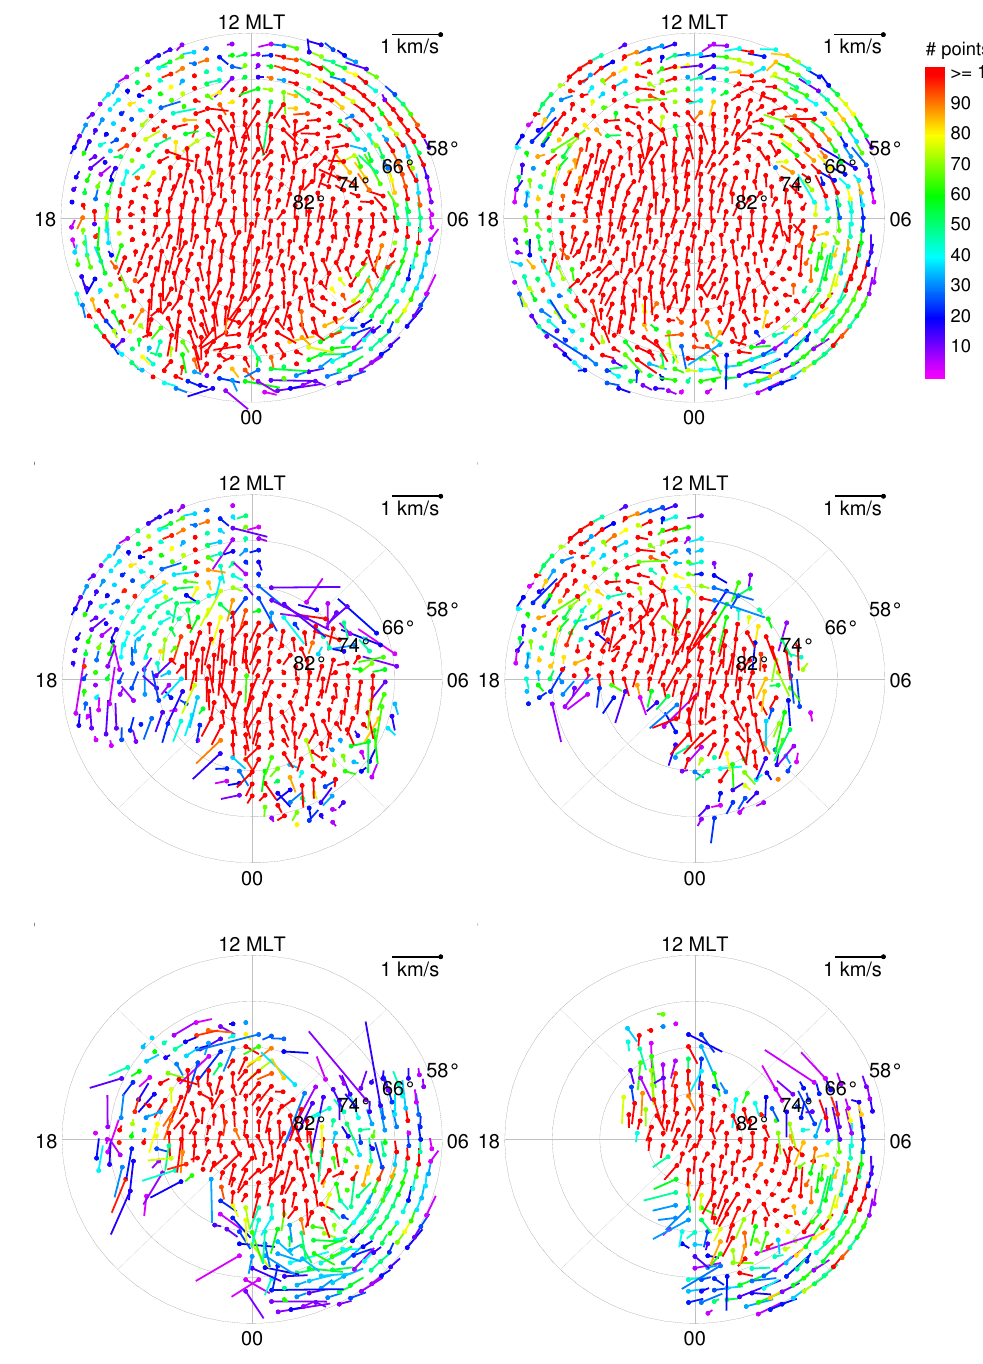
Fig. 5. Top: EDI convection velocities, measured from February 2001 through March 2006, mapped into the ionosphere at latitudes above 58 ◦ in SM coordinates for the Northern (left) and Southern (right) Hemispheres. The vectors emanating from the bin centers show the convection velocities, scaled as shown by the arrow in the upper right part. The color of the vectors indicates the number of mapped EDI vectors used to form the average in each bin. Middle: convection velocities and coverage for Northern Hemisphere summer (June to August). Bottom: same for Northern Hemisphere winter (December - February).